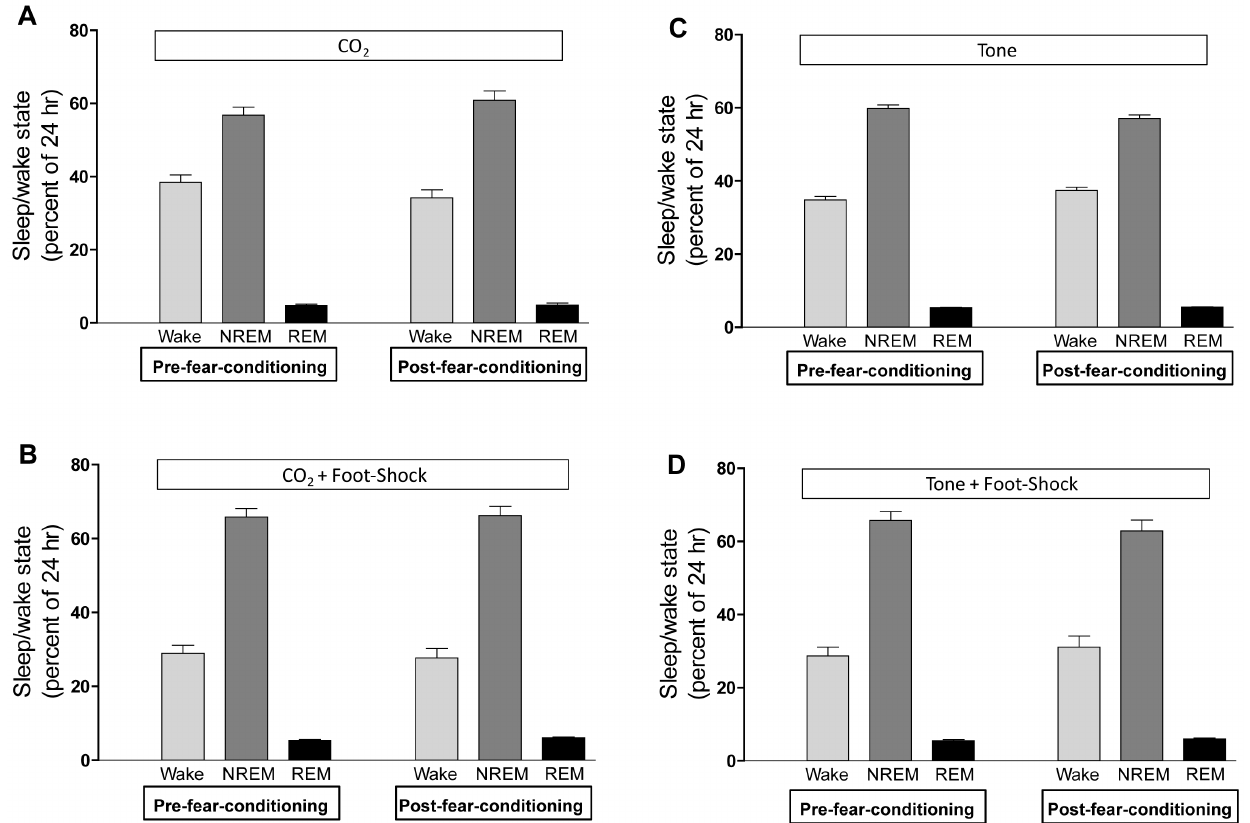
Figure 8. Shows the percent of time spent in wakefulness, NREM sleep, and REM sleep in the 24 hour period immediately post-fear- conditioning was compared to the same 24 hour period on the day prior to fear-conditioning for each group. Differences in time spent in each sleep state between pre- and post-fear conditioning were assessed by paired Student’s t-test. There were no significant differences in any of the four groups before fear conditioning compared to after fear conditioning for any sleep/wake